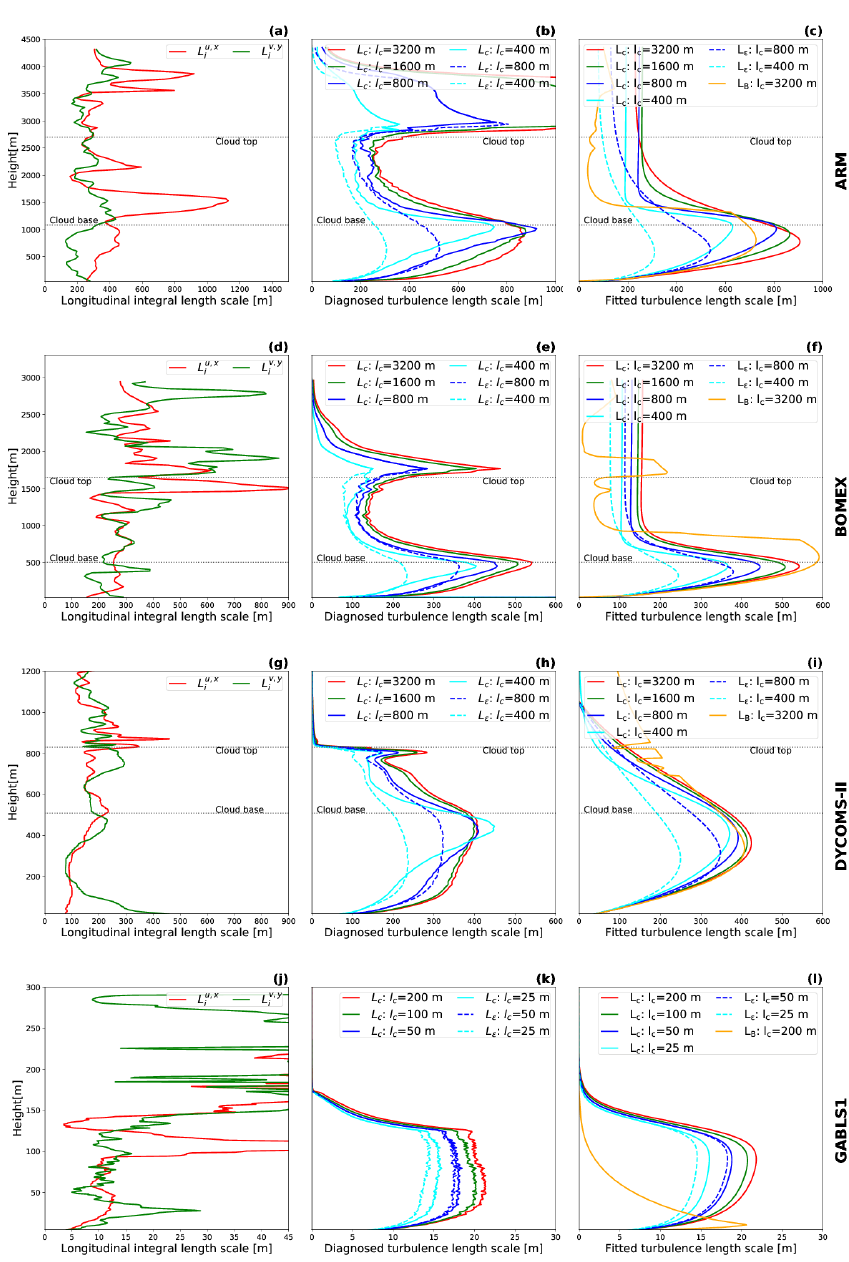
Figure 3. As in Figure 1, but comparison of the longitudinal integral turbulence length scales (see Equation (25)) for the zonal wind, L u , x , and the meridional wind, L v , y is computed for the period one i i hour before the end of the simulation ( a , d , g , j ); diagnosed turbulence length scales computed from the effective dissipation rate, L c ( l c ) (see Equation (23)); and the dissipation rate, L (cid:101) ( l c ) (see Equation (24)), ( b , e , h , k ); and their respective fits with the relationship in Equation (26) ( c , f , i , l ). The parametrized turbulence length scale according to Equation (18) in [16], L B , is also presented ( c , f , i , l ). The fits for the ARM and BOMEX cases are done only with data below the cloud top (indicated by horizontal